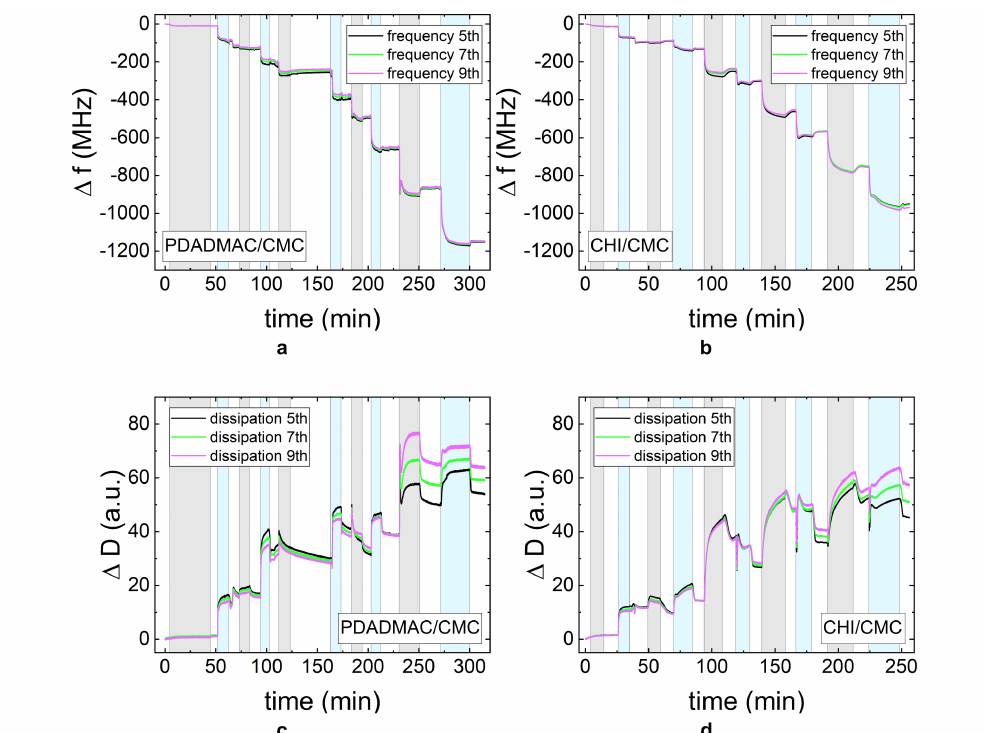
Figure 3. The change in frequency ∆ f ( a , b ) and dissipation ∆ D ( c , d ) measured by quartz crystal microbalance experiments with dissipation monitoring (QCM-D) for the PEMs PDADMAC/CMC and CHI/CMC. The gray region is the time period in which the polycation is adsorbed and the blue region in which the polyanion is adsorbed. The different curves in one plot represent different overtones of the measured intensity (5th, 7th, and 9th). All PE concentrations were set to 1g/L, and the pH-value was maintained at pH =